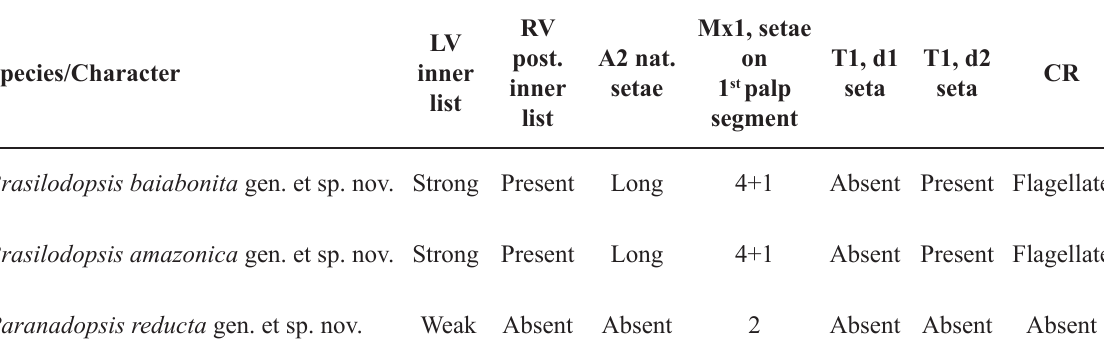
European Journal of Taxonomy 762: 1–48 Table 3. Comparative morphology of the two new genera described in this paper.